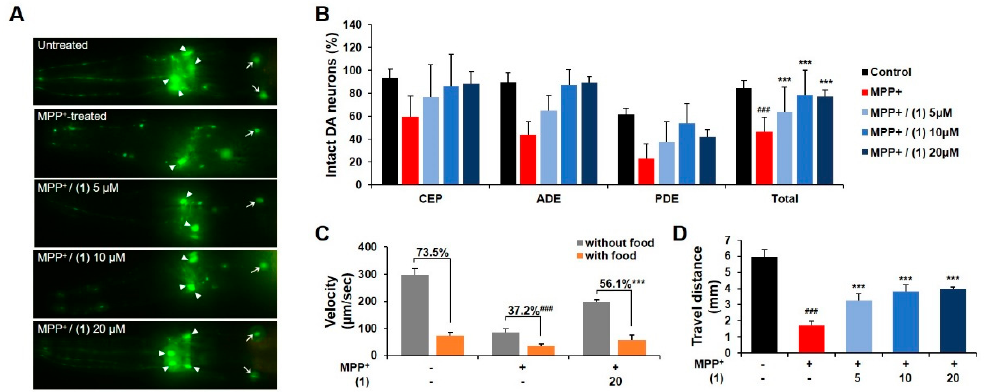
Figure 4. Neuroprotective effects of synthesized 1 on the DA neurodegeneration in the MPP + -exposed C. elegans . ( A ) GFP fluorescence signals of CEP (arrowhead) and ADE (arrow) in the Pdat-1::GFP nematode were photographed at 400× magnification. ( B ) The viability of all eight DA neurons was scored by inspecting the GFP expressions of Pdat-1::GFP nematode. ( C ) The velocity of wild-type nematodes was observed in the presence or absence of food ( E. coli OP50) and the basal slowing response was calculated. ( D ) The travel distance of wild-type nematodes was recorded for 20 s under a dissecting microscope. Statistical significance was determined by one-way ANOVA; ### p < 0.001 compared with vehicle alone; *** p < 0.001 compared with MPP ⁺ -treated control.